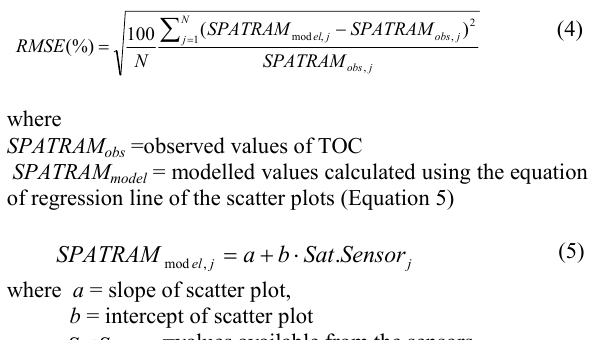
SensorSatbaSPATRAM . ⋅+= jjel ,mod where a = slope of scatter plot, b = intercept of scatter plot Sensor Sat .